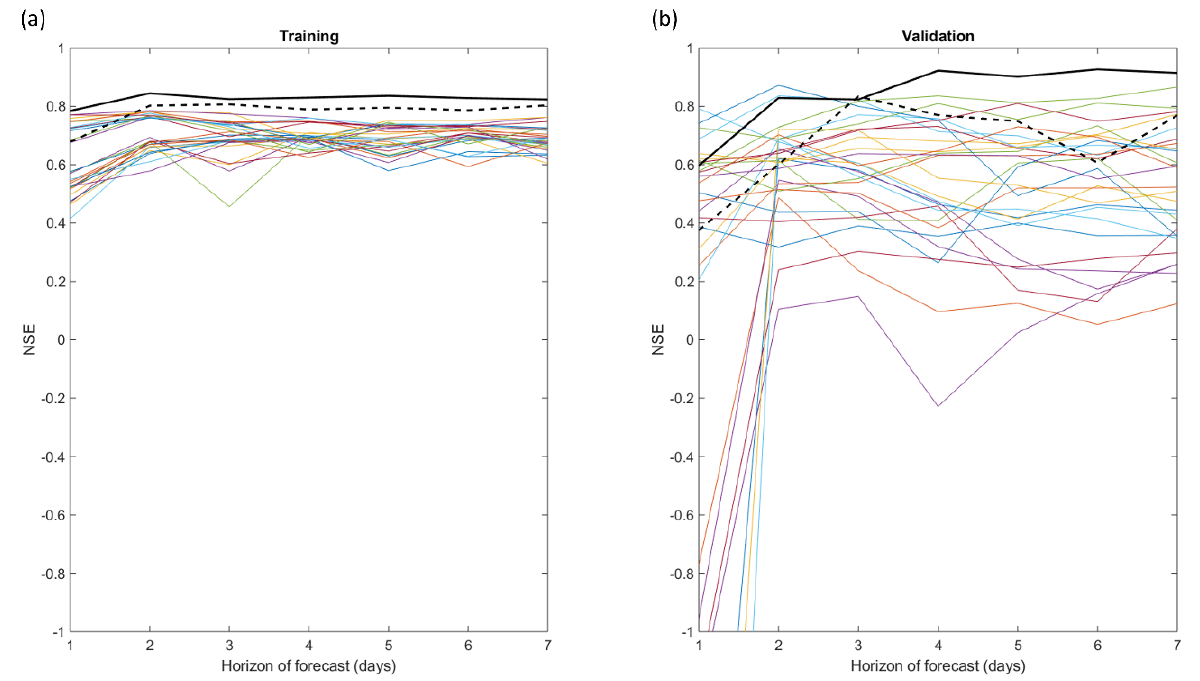
Figure 15. NSE evolution for Androscoggin watershed in 2012. ( a ) Training, ( b ) Validation. Colored lines for each pixel, dotted line for the distributed model, and full line for the global one.